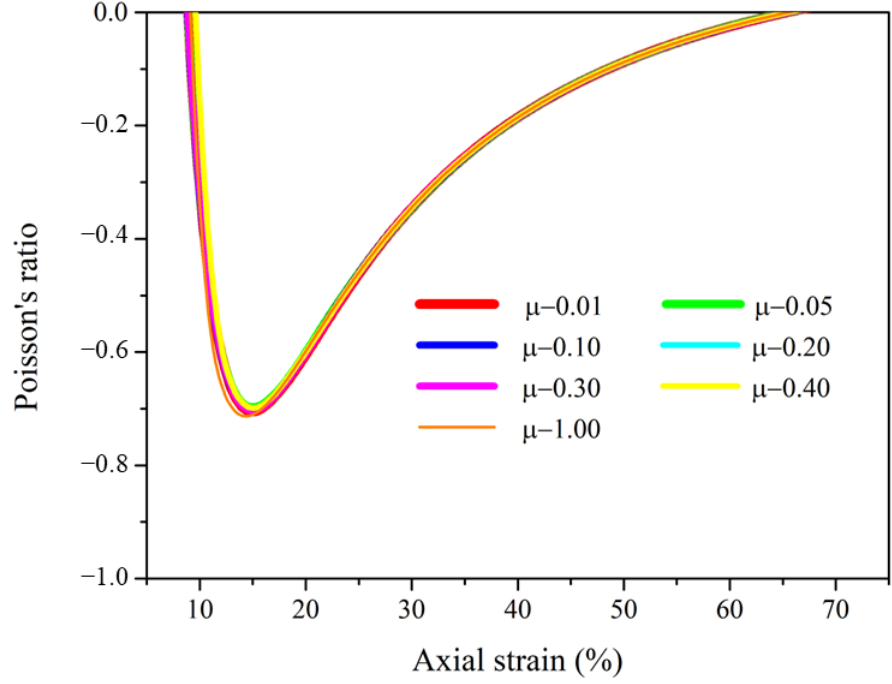
Figure 7. The effect of friction coefficient between yarn components on the Poisson’s ratios of auxetic yarns.